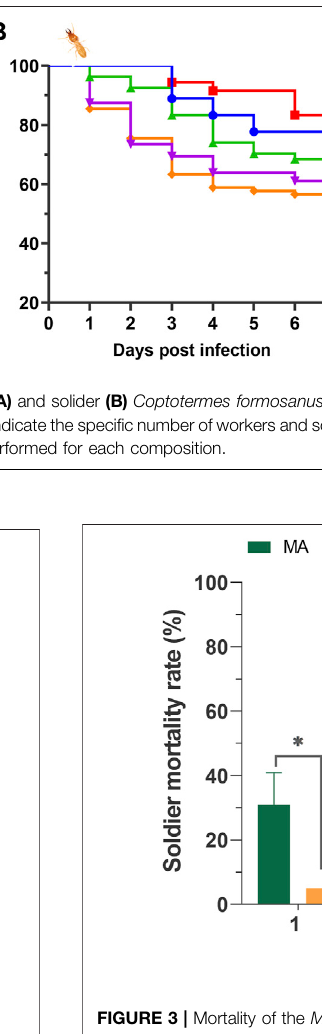
FIGURE 3 | Mortality of the Metarhizium anisopliae- infected soldier Coptotermes formosanus in the mono-caste group (group size = 20). Data represent the mean ± standard error of the mean (SEM). Differences between the mortality of the infected and control groups were statistically analyzed using the independent Mann – Whitney u -test ( p < 0.05). MA, M. anisopliae -infected group; TW, Tween-80-treated control